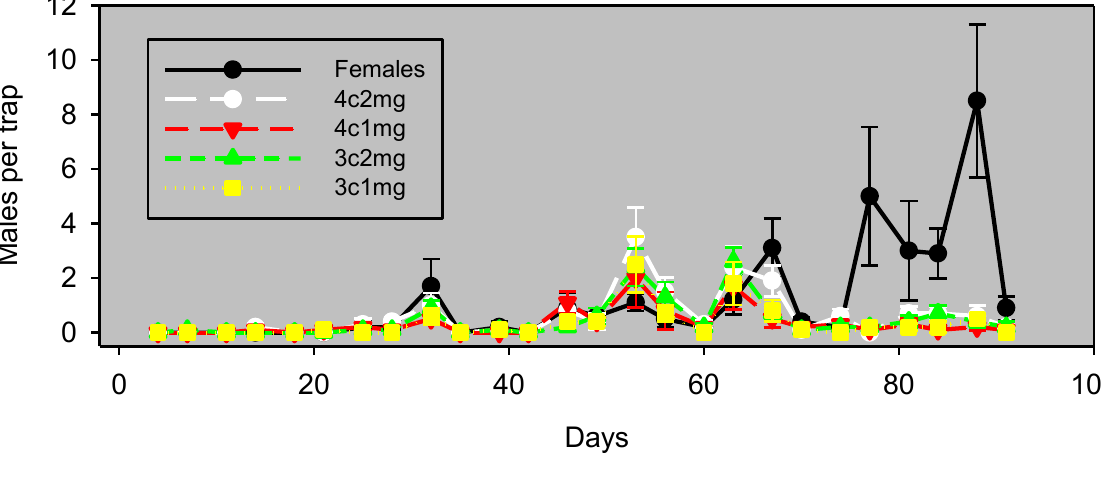
Figure 2. Experiment 2: males captured (mean ± SE) in almonds, by monitoring the interval in wing traps baited with unmated females or artificial lures, starting March 29, 2012. Blocks were 37 m apart, and traps within blocks were 18 m apart. The lure preparation is as in Table 2: 4c2mg, 2 mg of the four-component formulation; 4c1mg, 1 mg of the four-component formulation; 3c2mg, 2 mg of the three-component formulation; and 3c1mg, 1 mg of the three-component